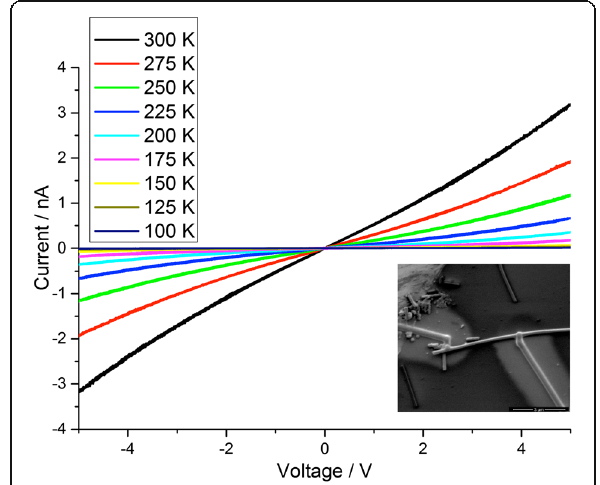
Fig. 4 I – V curves of SiNWs contacted with the FIB/GIS method at different temperature (from 100 to 300 K). Each curve represents two voltamperogrames cycles. In the inset , a SEM image of the measured SiNW taken at 500 V of acceleration voltage. The halo is well visible